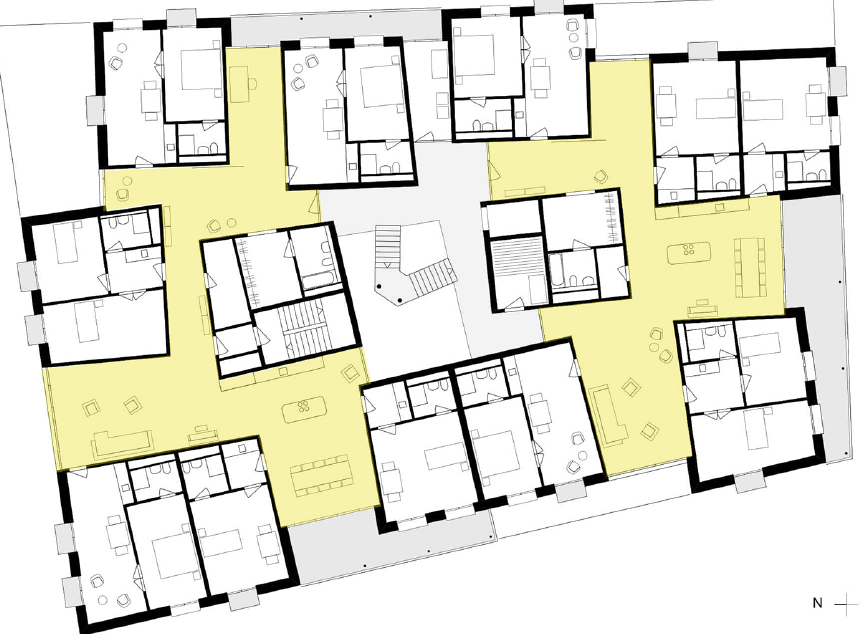
Figure 14. Mehr als Wohnen (plan of cluster apartment), Zurich, 2015, by Duplex Architekten. Source: McMaster (2016). Note: the highlighted areas correspond to the shared spaces.